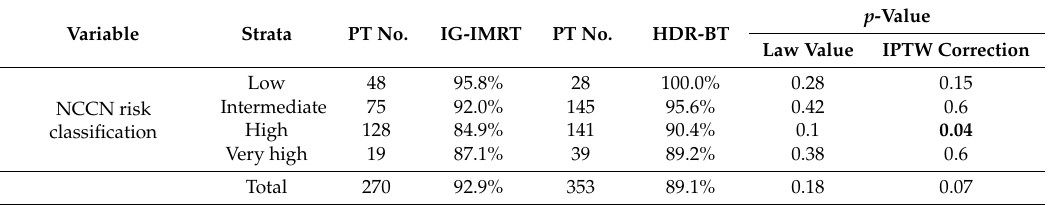
Table 2. The five-year biochemical control rates between treatments.